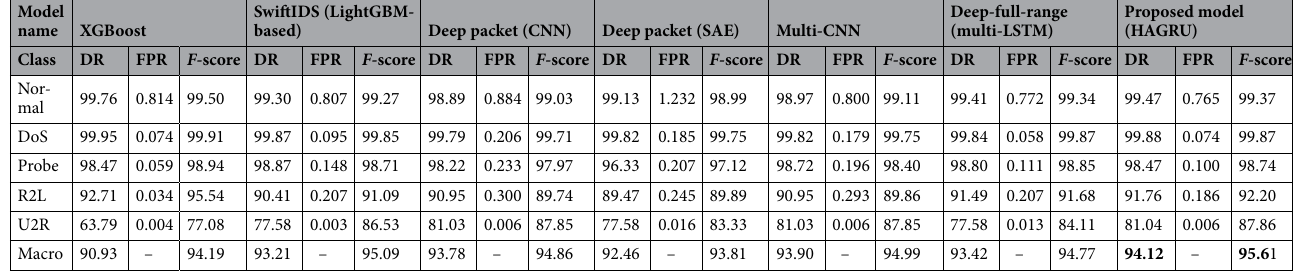
Table 4. Performance comparison of each model in NSL-KDD dataset (units: %, bold indicates the best value).